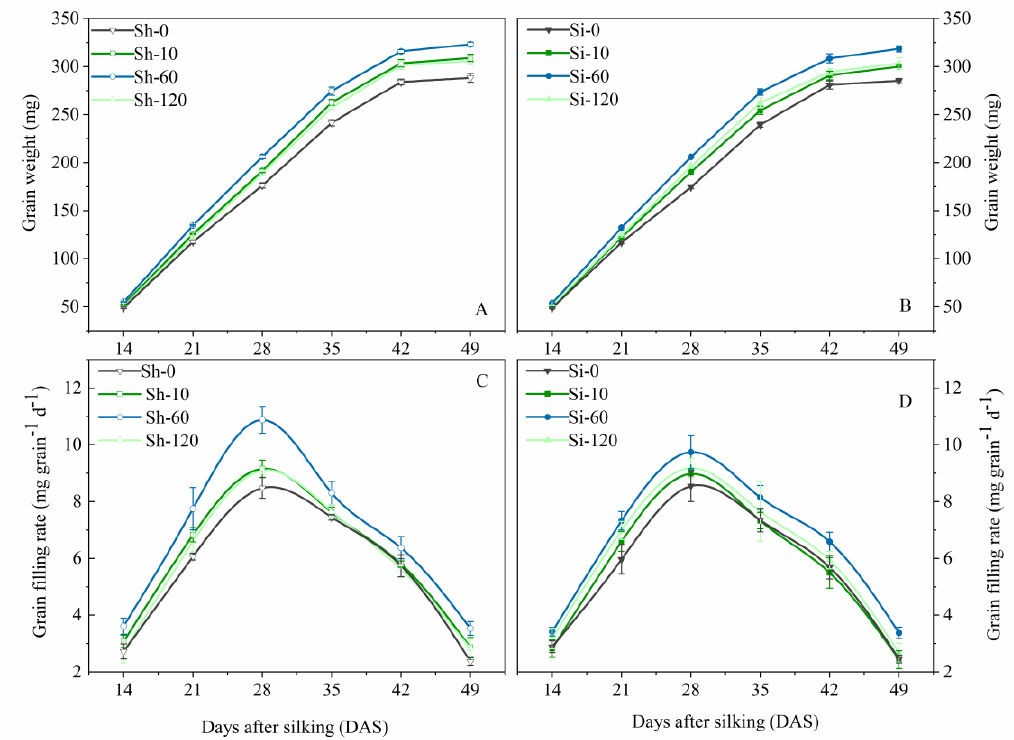
Figure 2. E ff ects of GA 4 + 7 applications on grain weights and grain-filling rates of maize. Sh-0, Sh-10, Sh-60 and Sh-120 represent shank-treatments with GA 4 + 7 at the rates of 0, 10, 60, and 120 mg L − 1 , respectively. Si-0, Si-10, Si-60 andSi-120 represent silk-treatments with GA 4 + 7 at the rates of 0, 10, 60, and 120 mg L − 1 , respectively. The vertical bars represent the ± the standard error of the mean (n = 3).